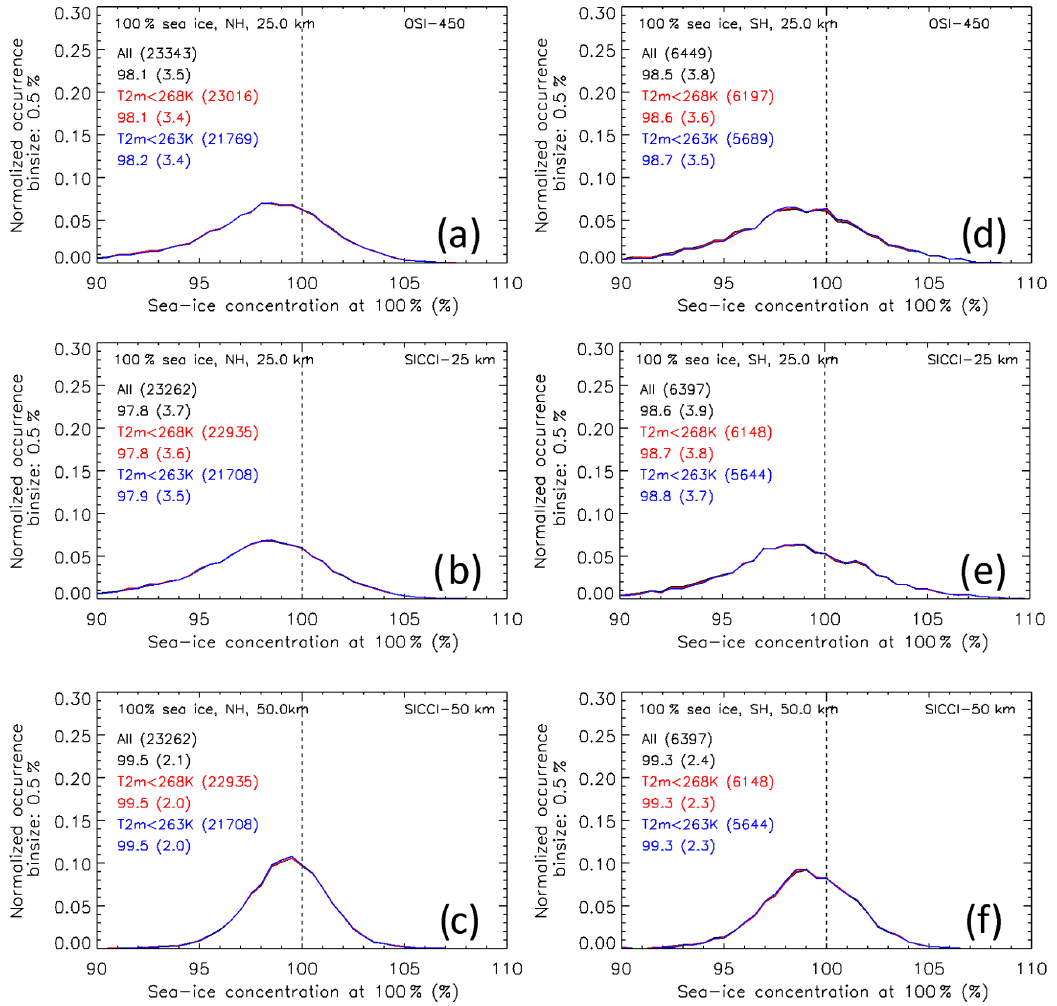
Figure 11. SIC distribution around SIC = 100% from the RRDP-2 data set for, from top to bottom, OSI-450, SICCI-25km and SICCI- 50km in the Arctic (a–c) and the Antarctic (d–f) . The unfiltered distribution is shown (no threshold at 100% SIC) by combining ice_conc and raw_ice_conc_values variables. Black, red and blue curves and numbers refer to all data and data limited to ERA-Interim 2m-air temperatures < − 5 and < − 10 ◦ C respectively. The numbers behind the limitation text (e.g. “all”) denote the count of data used; the numbers below denote the mean SIC and 1 standard deviation (in parenthesis) in percent SIC. Bin size is 0.5%. Distributions are normalized to give a total of